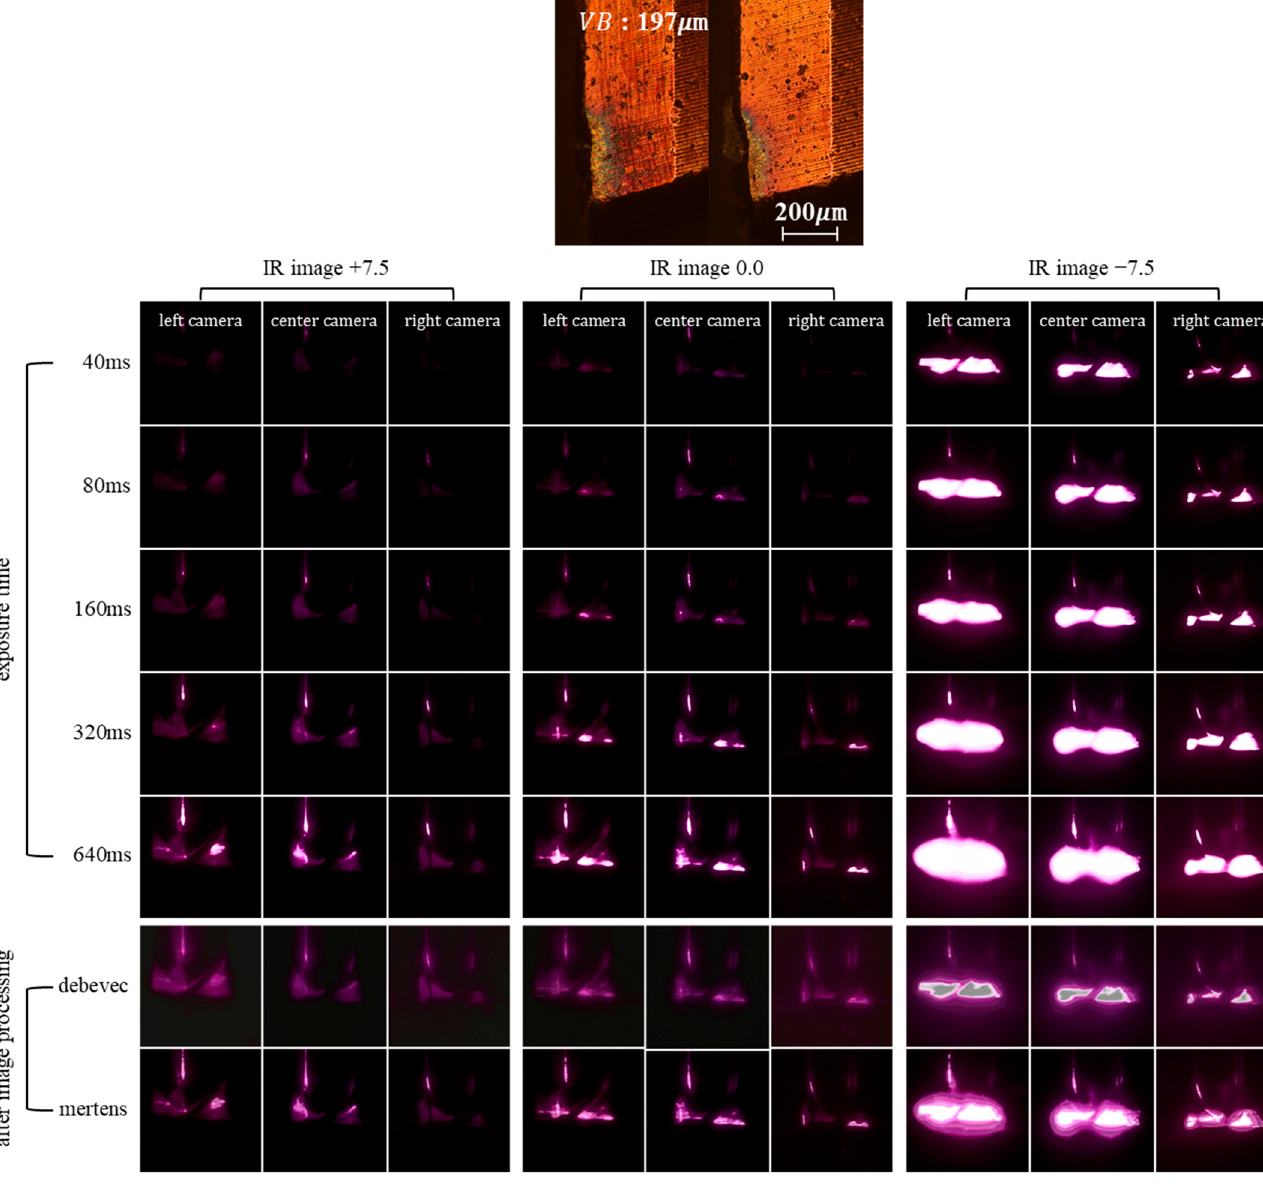
Figure 6. IR images of tool wear.